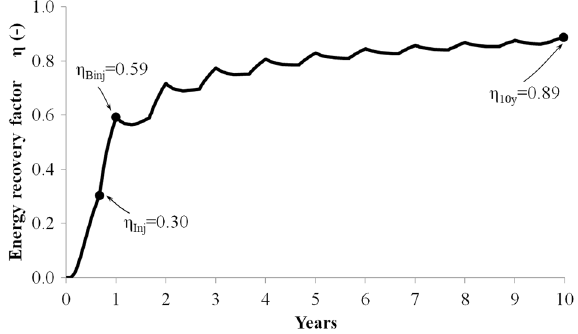
Fig. 11 Energy recovery factor during 10 years of